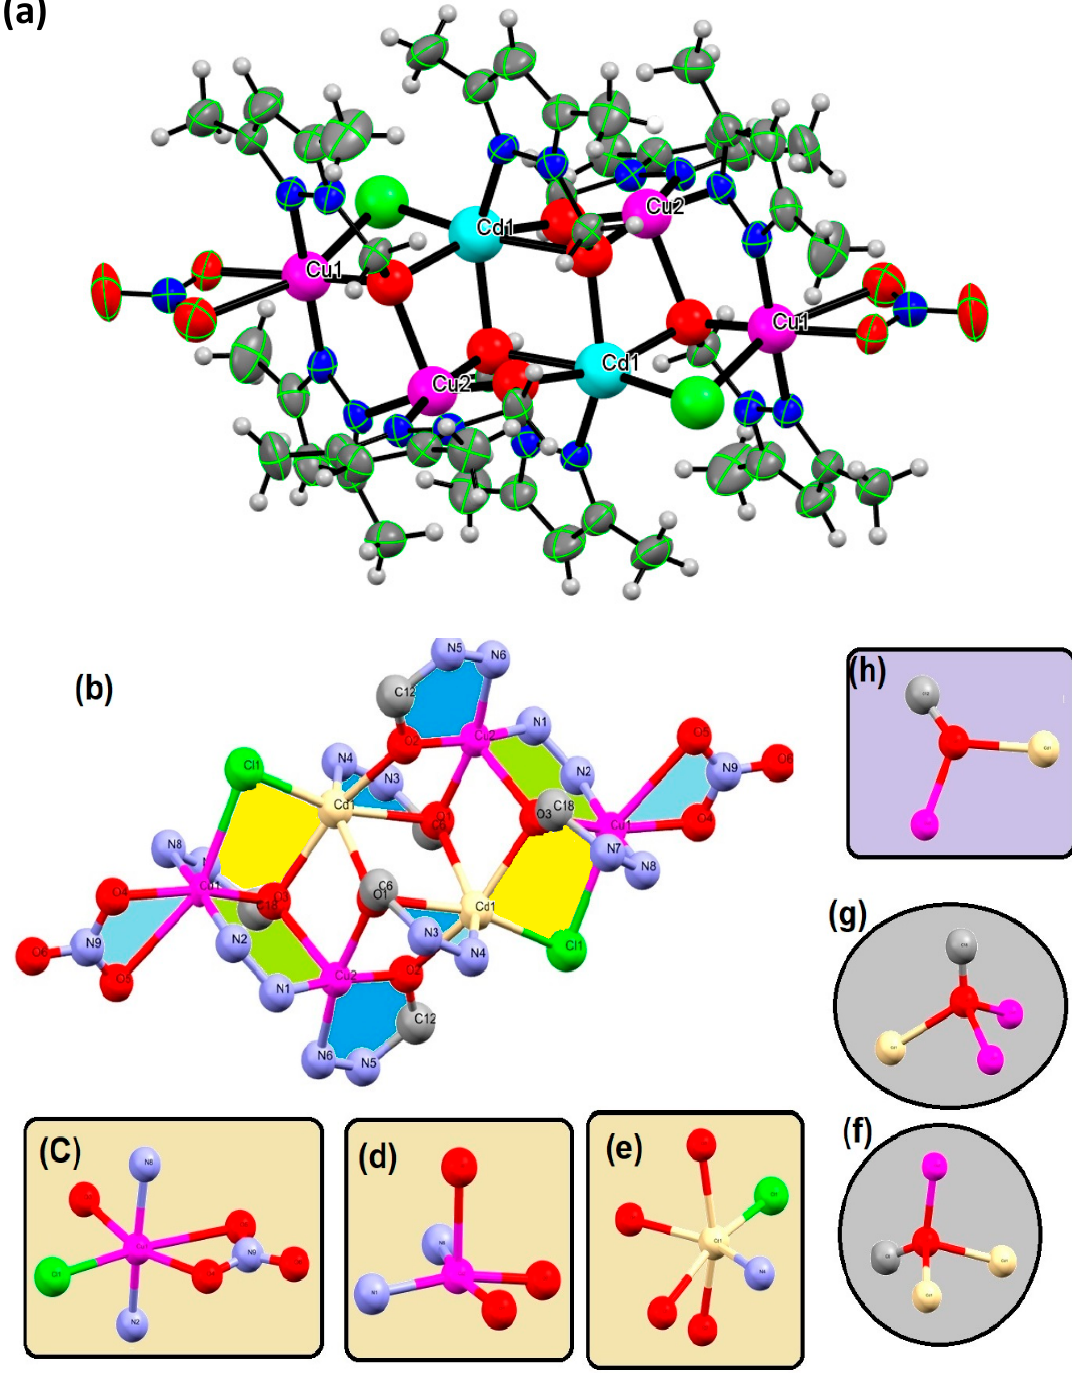
Figure 1. ( a ) ORTEP structure (50% probability) of the bimetallic cluster, ( b ) molecular structure without protons showing no water in the crystal lattice, ( c ) octahedral geometry around Cu(II) centers, ( d ) pyramid geometry around the other Cu(II) centers, ( e ) distorted octahedral geometry around Cd(II) centers, ( f ) di- µ 2 -methoxo-trigonal pyramid-O centers, ( g ) and ( h ) two di ff erent tertra- µ 3 -methoxo-tetrahedral-O